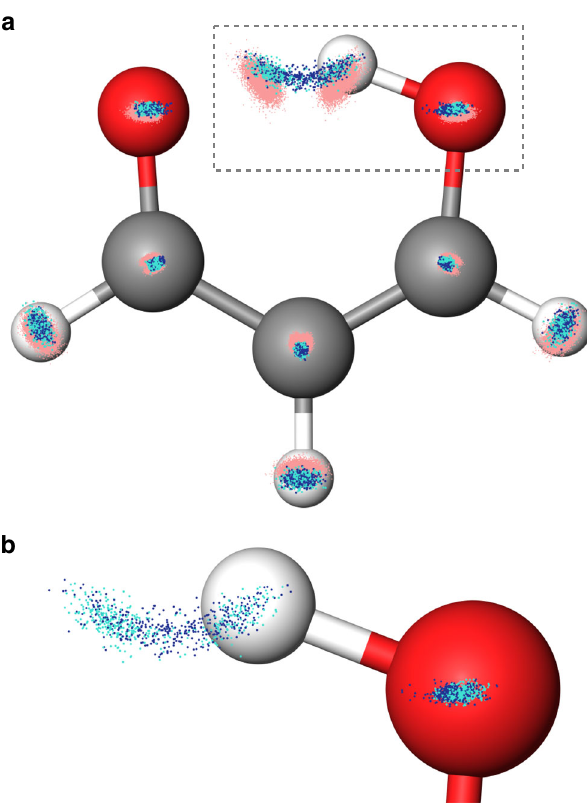
Fig. 6 The space of malonaldehyde conformers generated by all MD methods. a The training set of 2000 representative conformers selected from the classical MD trajectories ( red points ) by K-means sampling. Test points from an ab initio MD trajectory ( turquoise ) and the independently generated MD trajectory using the ML-HK model ( blue ) sample the same coordinate space (offset from the molecular plane for clarity). b A closer view of the region outlined with a dashed box for the ab initio ( turquoise ) and ML-HK ( blue )